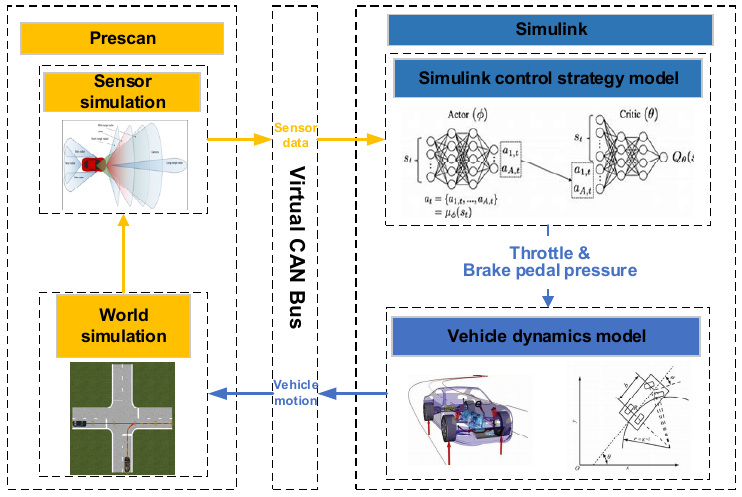
Figure 13. Cosimulation schematic diagram for Simulink and Prescan.